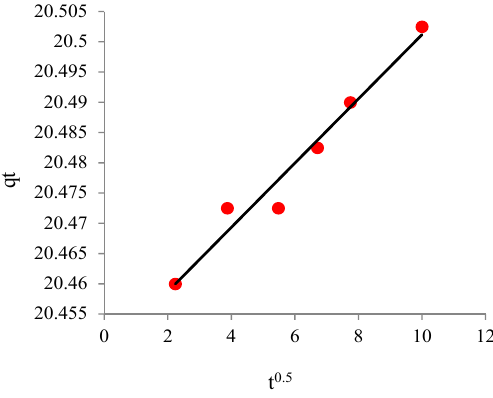
Fig. 17: Morris-Weber plot of cadmium adsorption onto polypyrrole/titanium dioxide nanocomposite